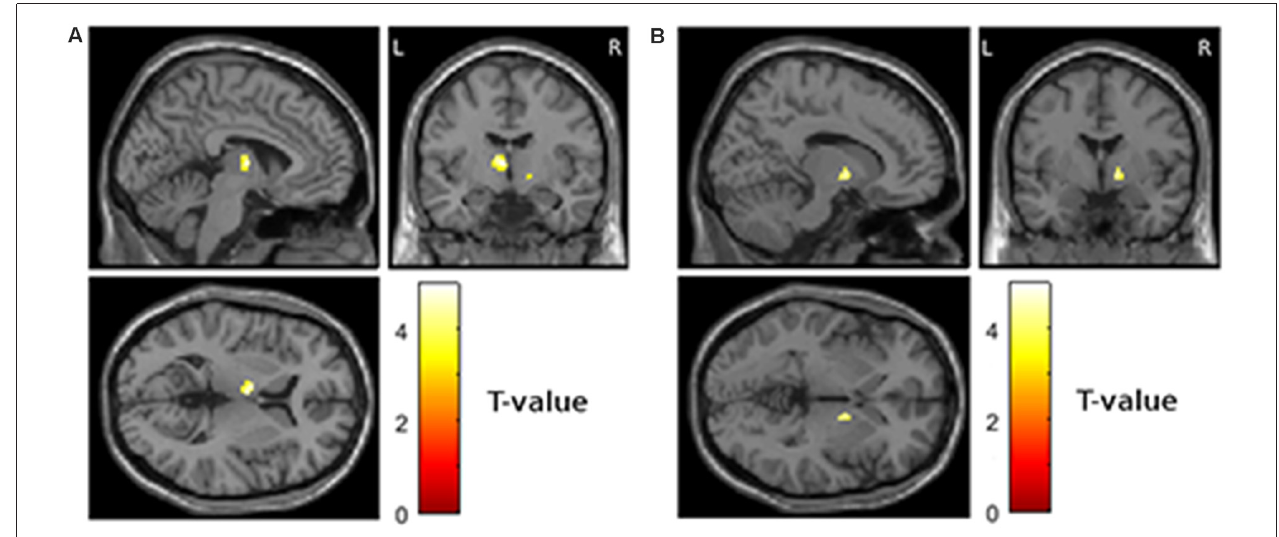
FIGURE 3 | Areas showing a relationship between increase in atrophy from visit 1 to visit 2 and worsening of depressive symptoms from visit 1 to visit 2 ( p < 0.001 uncorrected and more than 50 contiguous voxels in a cluster). (A) Left thalamus, MNI coordinates of peak voxel − 5, − 8, 6 (B) right globus pallidus, MNI coordinates of peak voxel 14, − 2, −